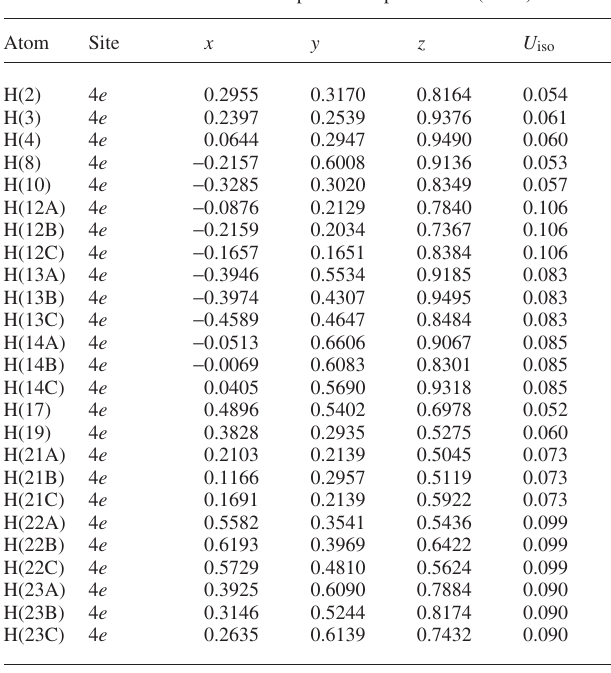
Table 2. Atomic coordinates and displacement parameters (in Å 2 )